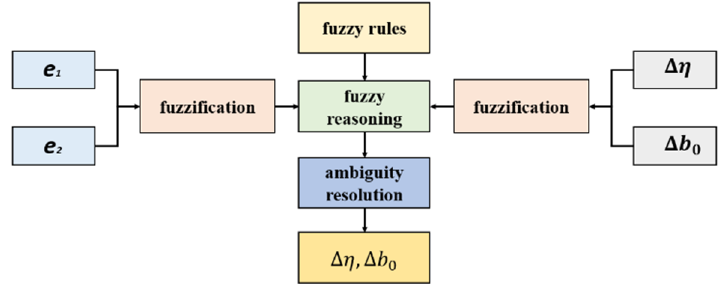
Figure 1. The η and b 0 correction algorithm based on fuzzy control.